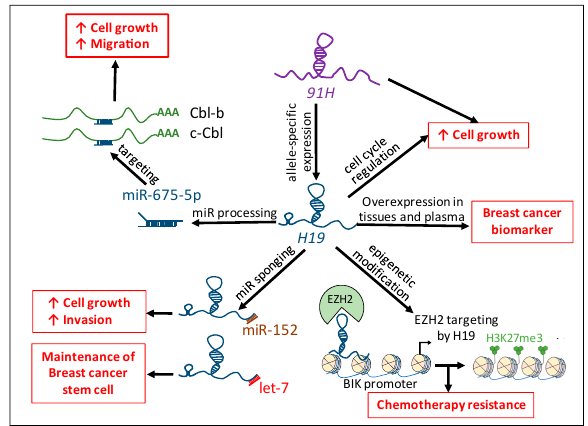
Figure 4. Implication of H19 in human breast cancer. The H19 lncRNA favors breast tumorigenicity by regulating the cell cycle, through the processing of miR-675-5p and the sponging of miR-152 and let-7, and regulating chemotherapy resistance through epigenetic modification. The H19 antisense, 91H , allows allele-specific expression of H19 and participates in breast cancer cell biology. H19 and miR-675 are overexpressed in breast cancer tissues and plasma of patients and could be used as tumor biomarkers. H3K27me3: Trimethylation of lysine 27 on histone H3. Red arrows indicate an increased phenotype.